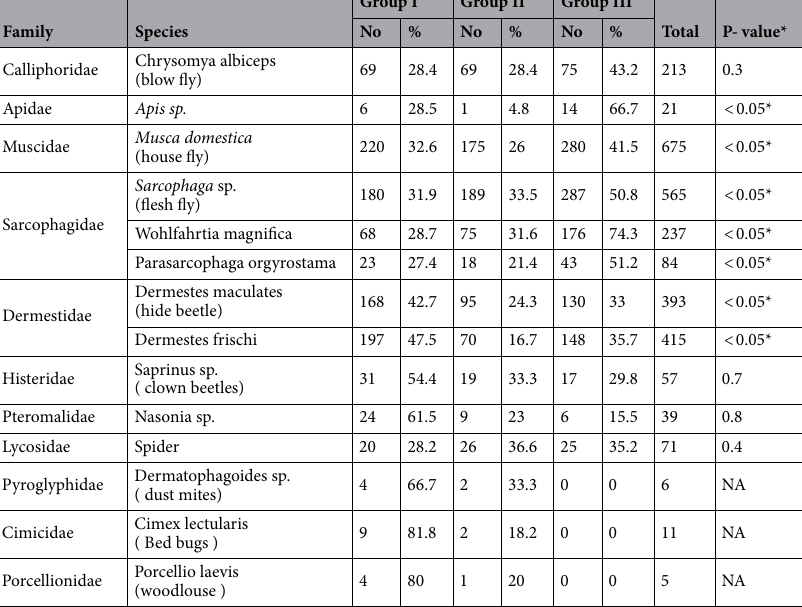
Table 3. Comparison between isolated species of Arthropods in the studied groups during the whole period of the study (from 0 to 31 days).